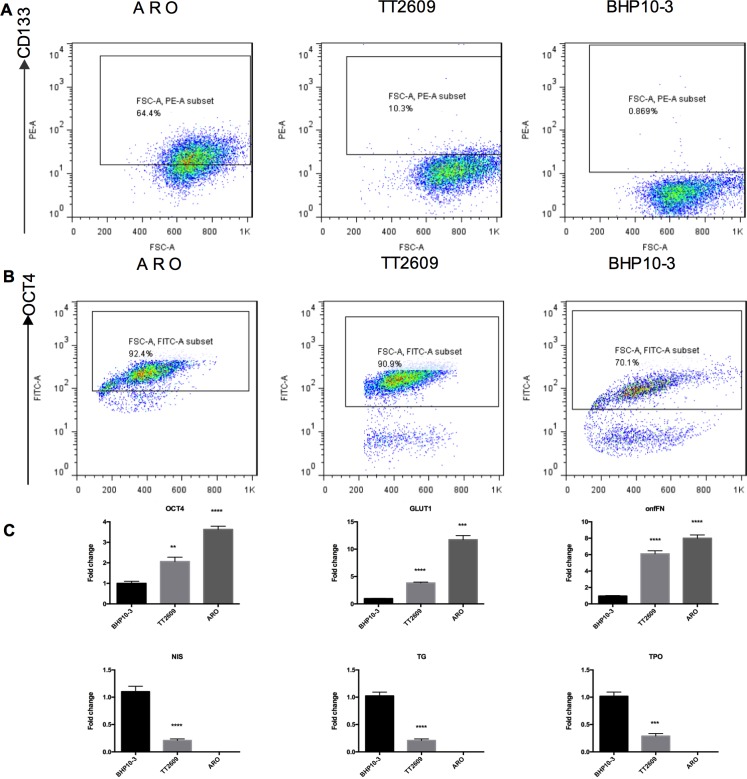
CD133 and OCT4 detection in ARO, TT2609, and BHP10-3 cell lines and RT-qPCR findings.A. The proportion of CD133-positive cells in the ARO, TT2609, and BHP10-3 cell lines. B. The proportion of OCT4-positive cells in the cell lines. C. The relative fold changes of OCT4, GLUT1, onfFN, NIS, TG and TPO expression (control, BHP10-3 cells).